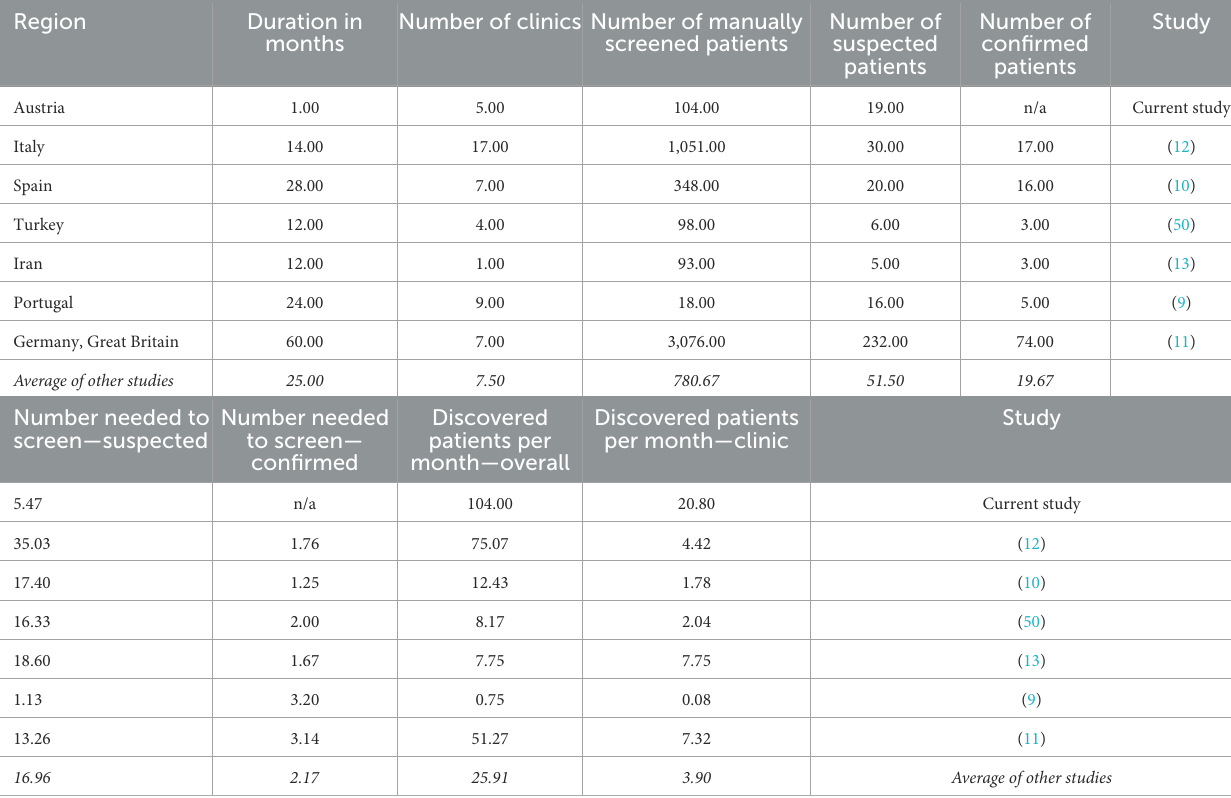
TABLE 4 Overview of published Pompe disease screening studies. Region Duration in